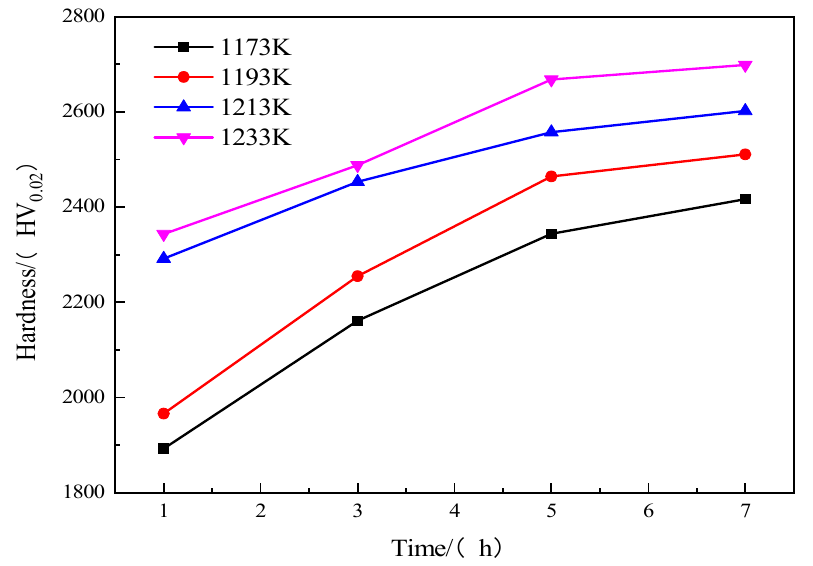
Figure 10. The hardness variation of vanadiumizing layer prepared at different heating temperatures and durations.